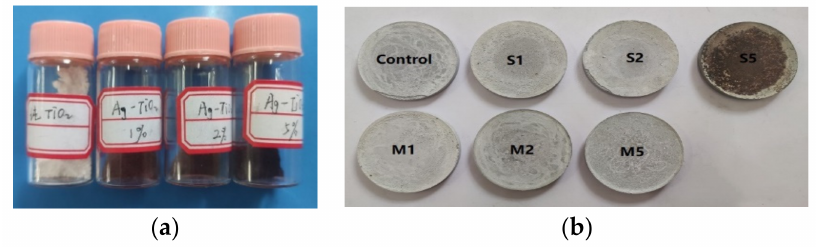
Figure 1. Nano Ag-TiO 2 powder sample ( a ) and Photocatalytic mortar test block ( b